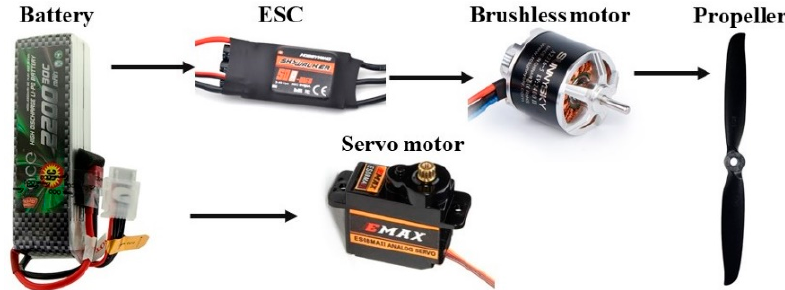
Figure 10. Propulsion system components and the servo motor of the UAV.